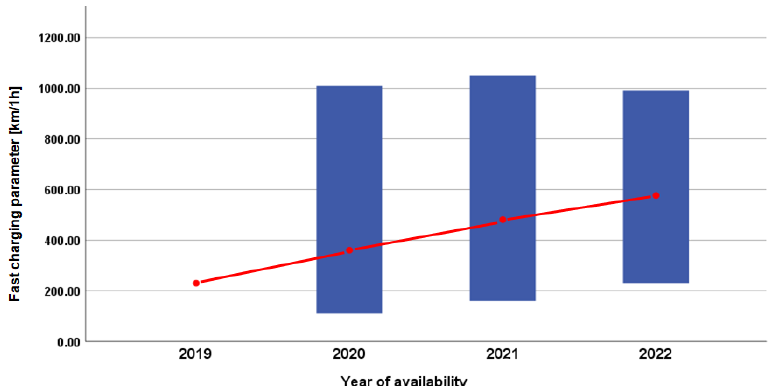
Figure 7. Range bar variation (min, max, mean) representation of energy efficiency vs. year of availability in market.